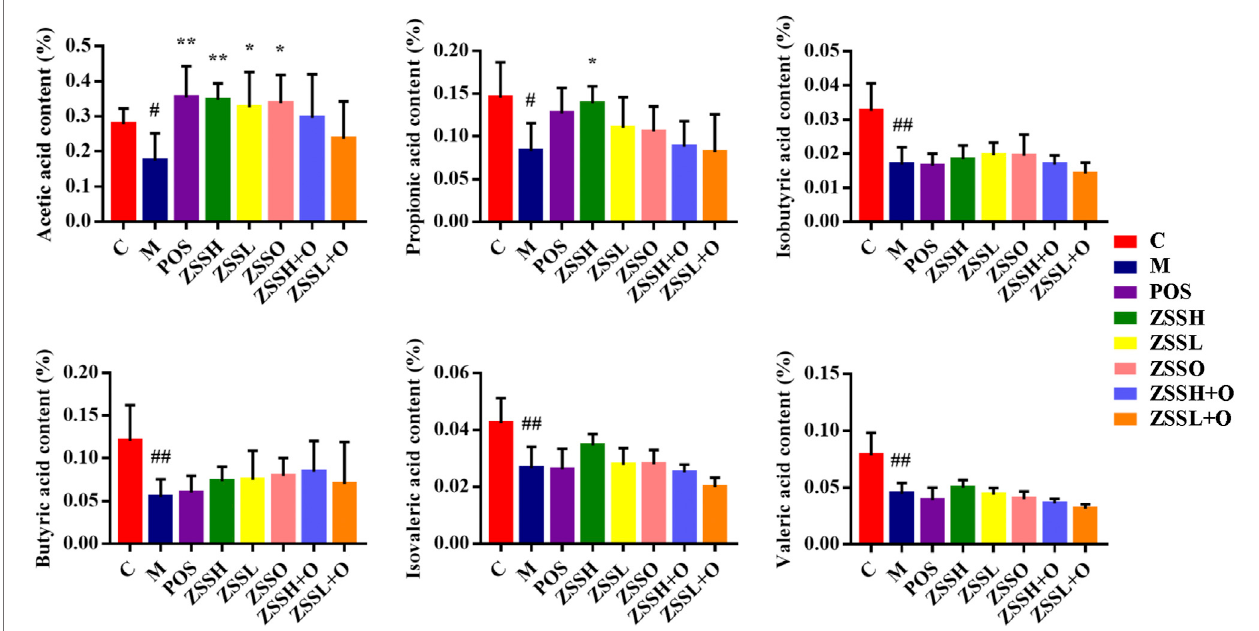
FIGURE7| EffectsofZSScomponentsonSCFAsinfeces.(C)controlgroup;(M)modelgroup;(POS)positivegroup;(ZSSH)high-doseZSSethanolextractgroup; (ZSSL)low-doseZSSethanolextractgroup;(ZSSO)ZSSoilextractgroup;(ZSSH+O)high-doseZSSethanol+oilextractgroup;(ZSSL+O)low-doseZSSethanol+oil extract group. Values are presented as the mean ± SD, n (cid:2) 6. # p < 0.05, ## p < 0.01: model vs control; * p < 0.05, ** p < 0.01: treatment vs model.